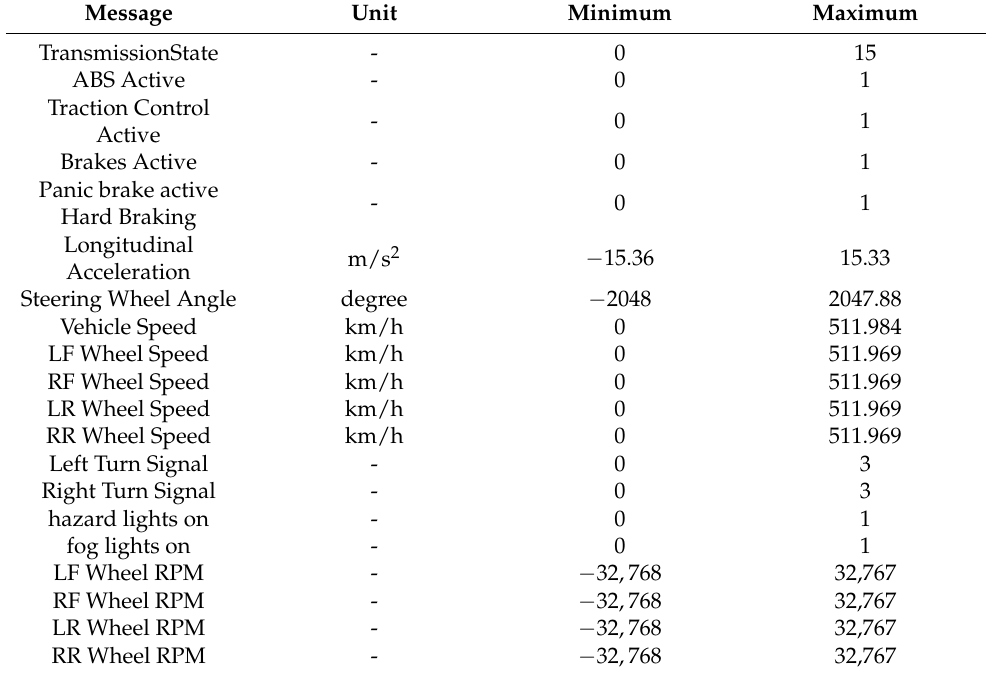
Table 1. CAN .dbc